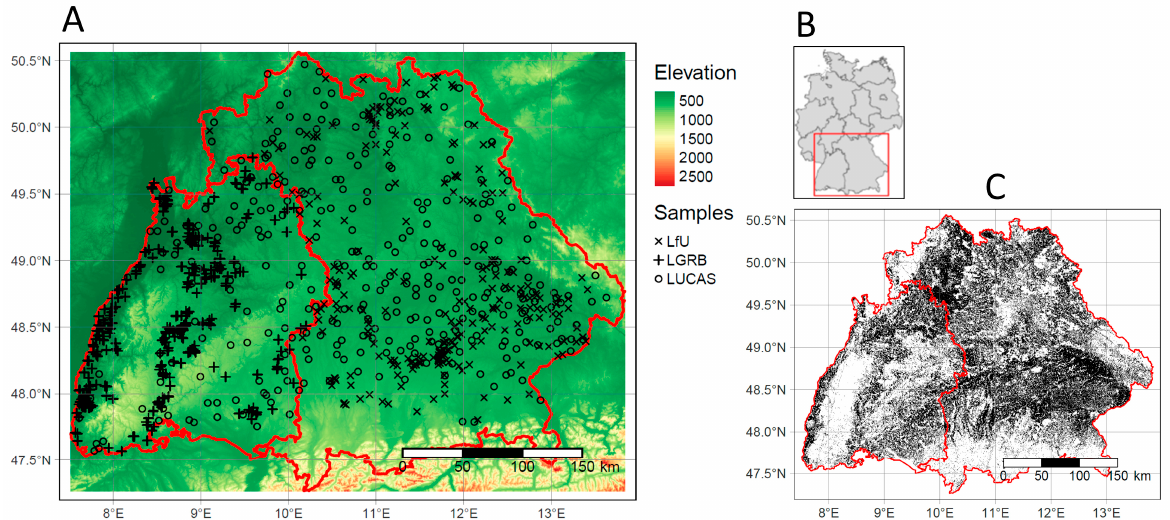
Table 1. Comparison of both federal states.